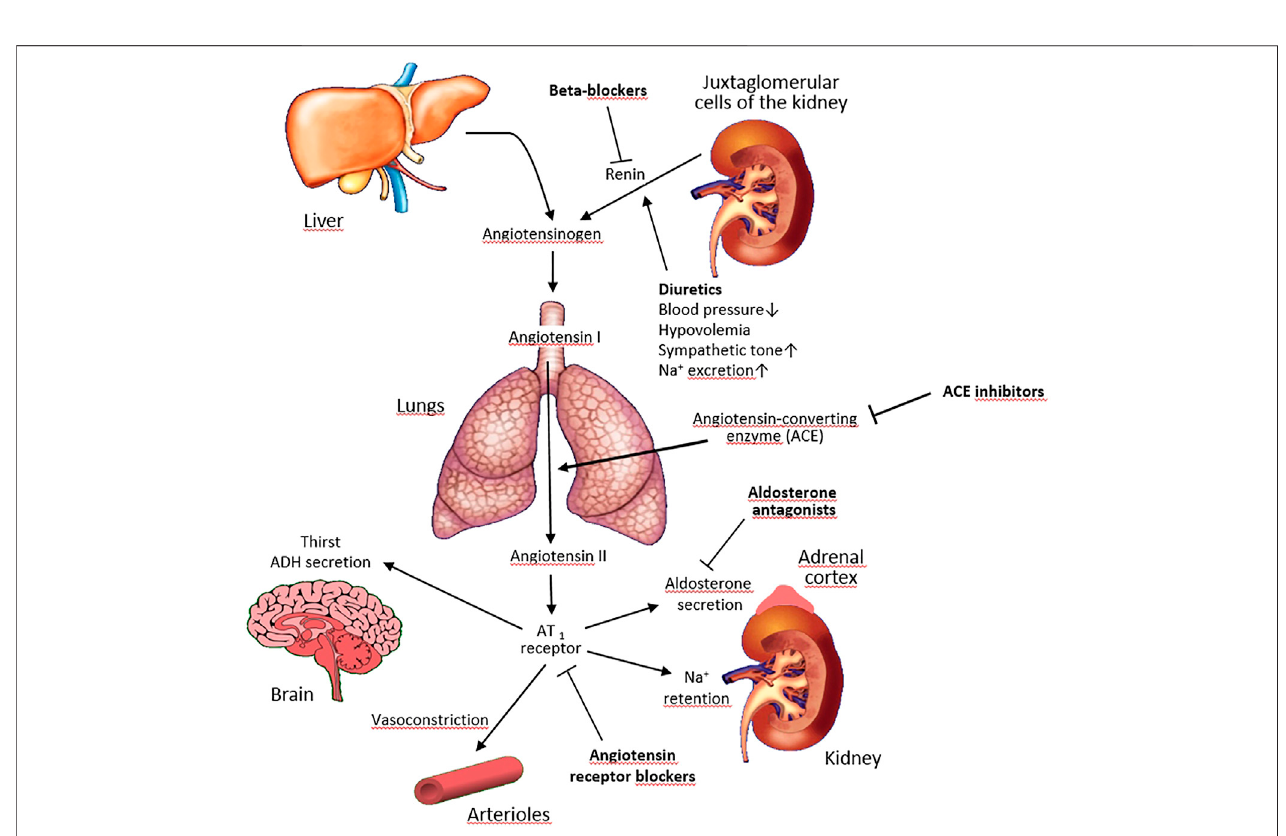
FIGURE 1 | Effects of antihypertensive drugs on the renin-angiotensin-aldosterone system. Pointed arrows indicate stimulation, blunted arrows – inhibition.